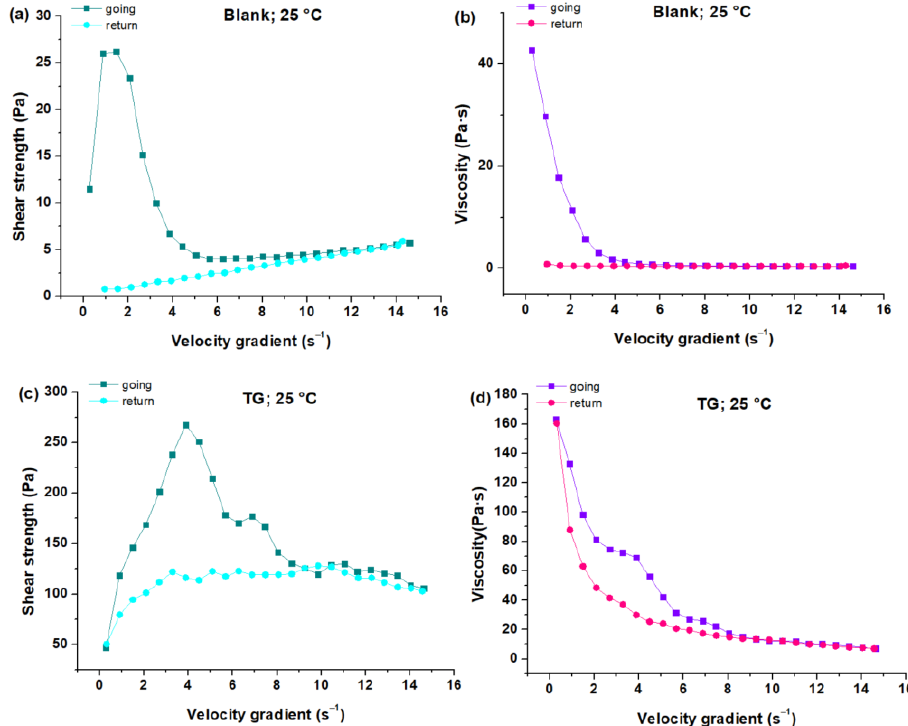
Figure 7. Shear stress curves as a function of the velocity gradient of the creams stored at 25 °C on day 28: ( a ) τ vs. D of the blank cream, ( c ) τ vs. D of the cream with TG. Viscosity curves as a function of the velocity gradient of the creams stored at 25 °C on day 28: ( b ) η vs. D of the blank cream, ( d ) η vs. D of the cream with TG.